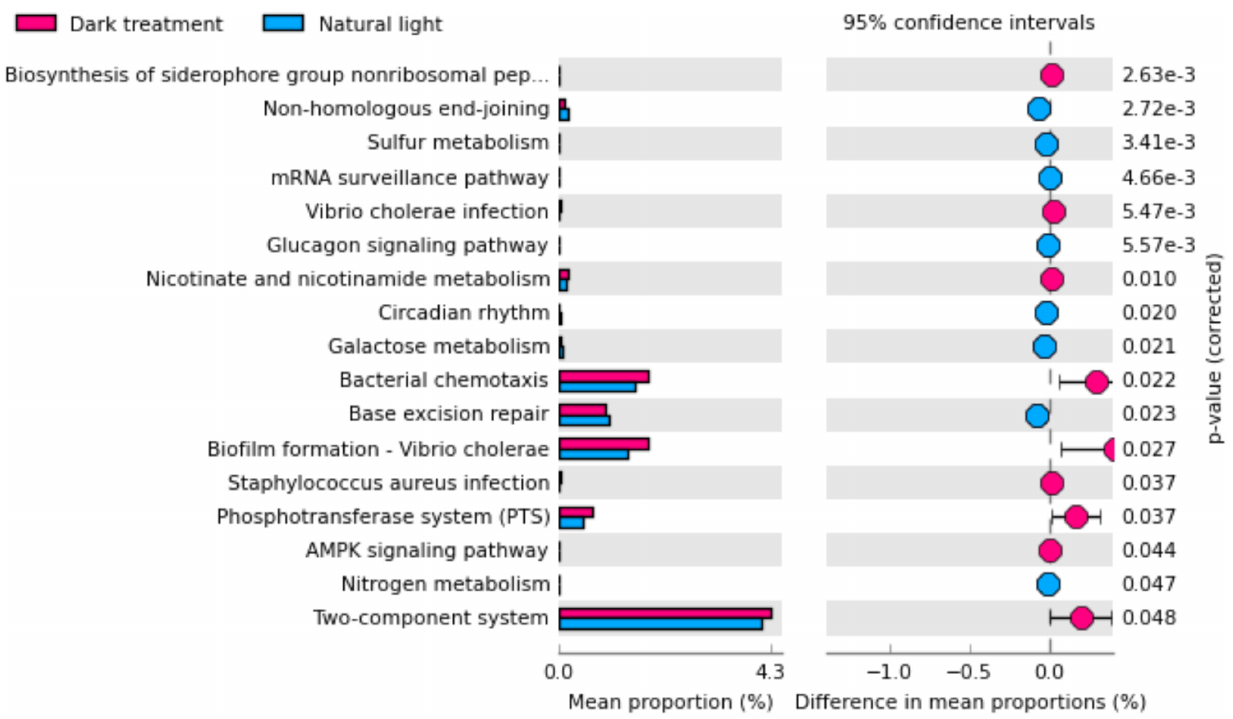
FIGURE 9 | The functional analysis was predicted from 16S rRNA gene-based microbial compositions. Differences were considered significant at P < 0.05 using an independent t